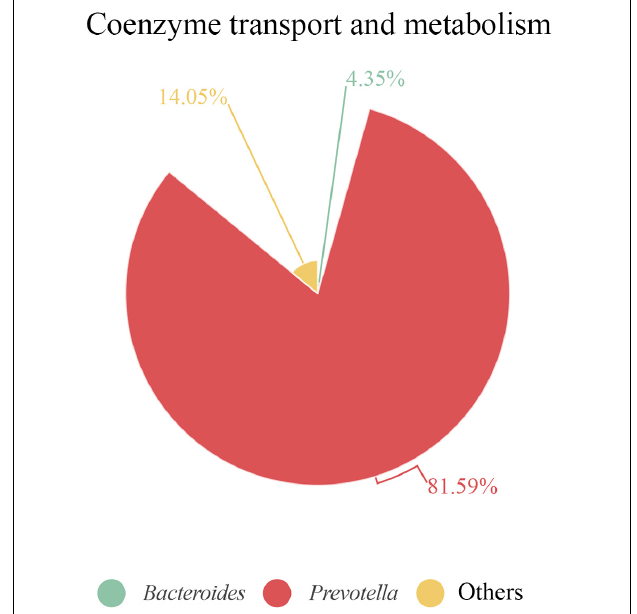
FIGURE 8 | Proteins associated with coenzyme transport and metabolism in S3 at genus level. Contribution of each genus is represented as the percentage of protein intensity of the genus assigned to each COG